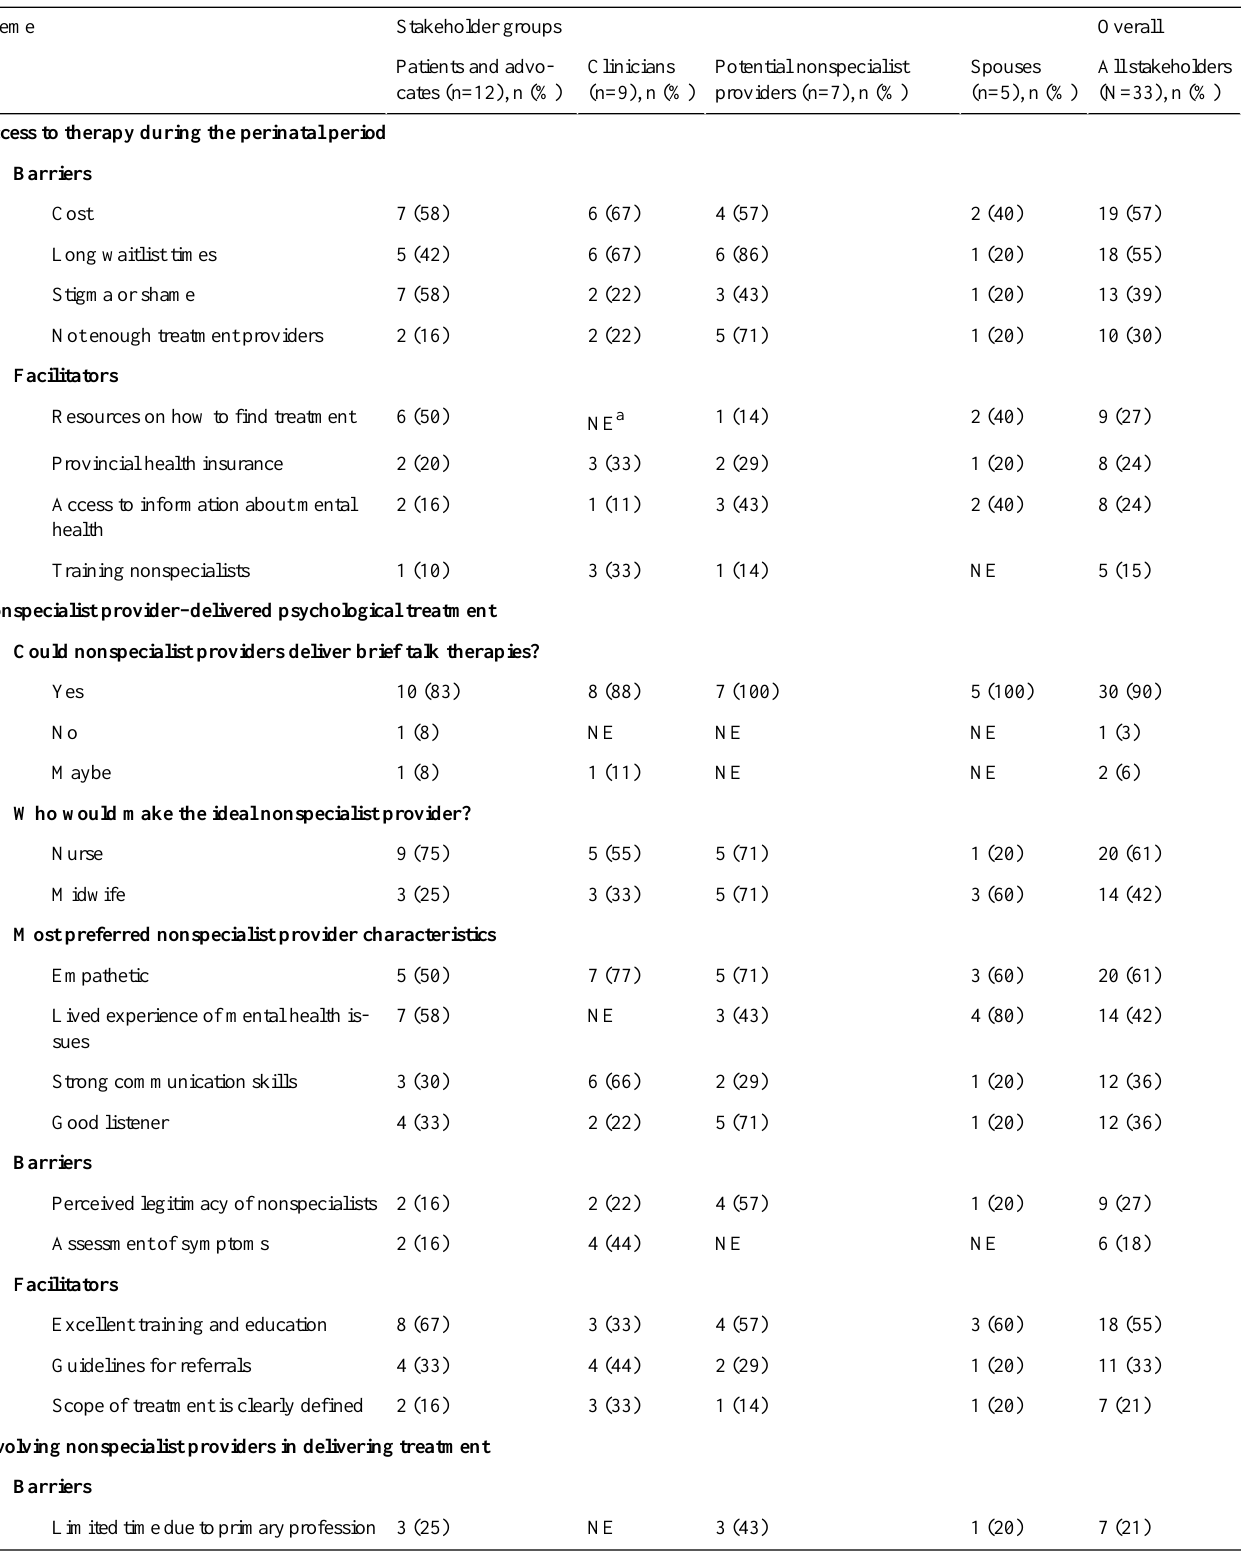
Table 2. Key themes related to accessing psychological treatment, accessing nonspecialist provider–delivered treatment, and involving nonspecialist providers in delivering